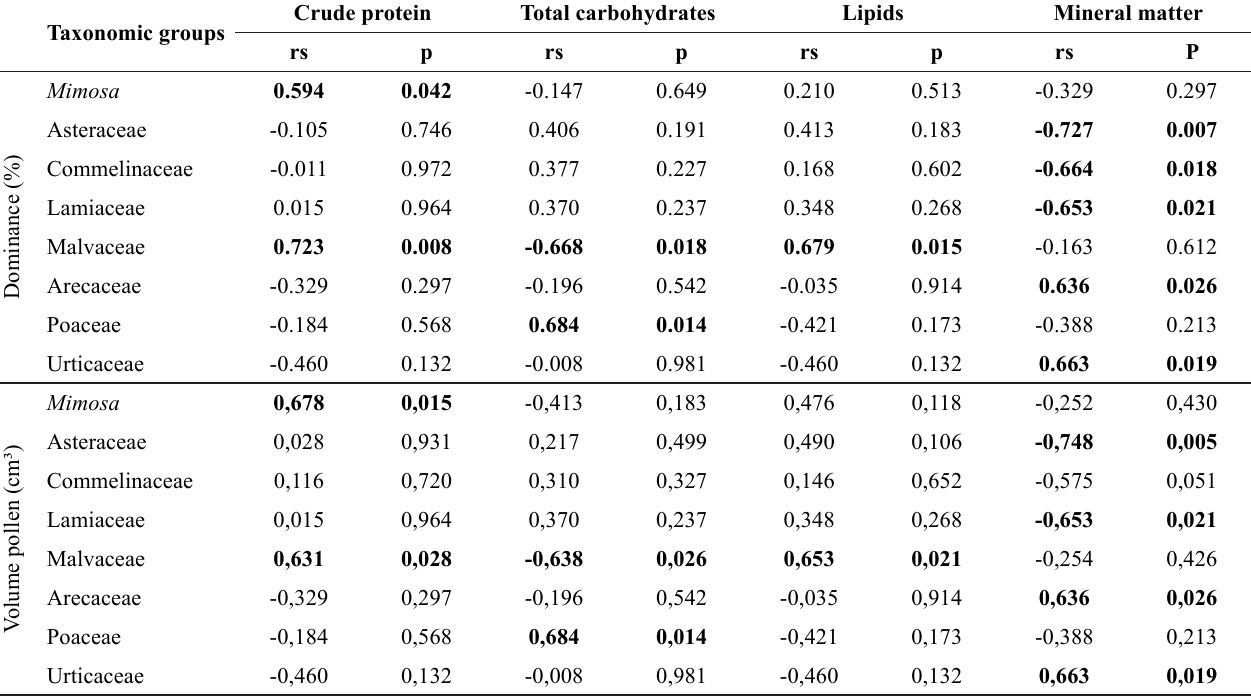
Table 3 . Correlation between taxonomic groups and chemical variables of bee pollen produced by Apis mellifera in a seasonal semideciduous forest in the State of Ceará, in the period from November 2012 to October 2013. The rs values are presented for dominance in the diet (% of pollen grains) and pollen volume of each plant